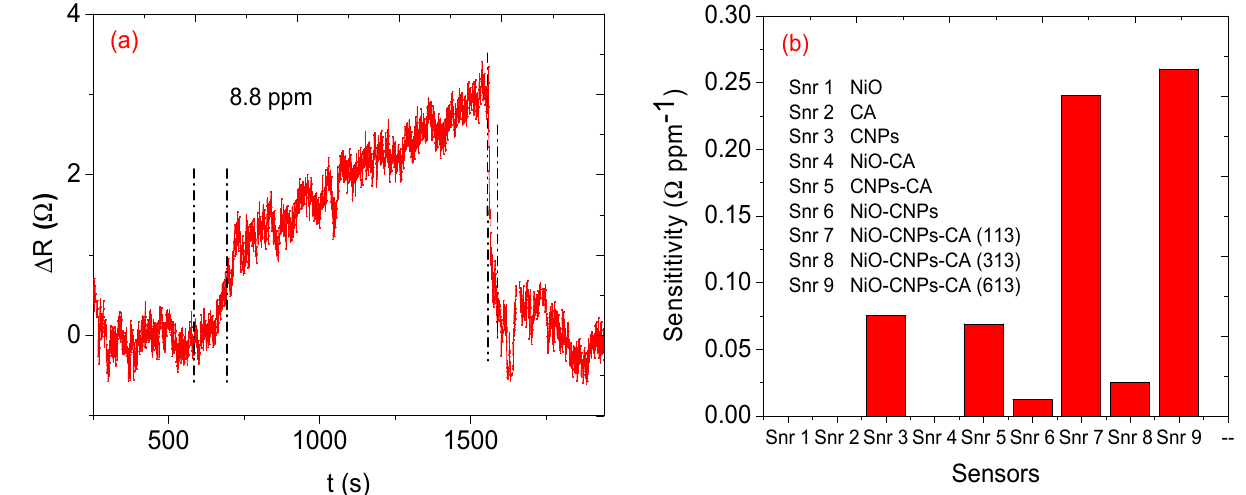
Figure 12. ( a ) Response-recovery time of Snr 7 and ( b ) sensitivity graph for mesitylene. Table 1. Response and recovery time of the sensors during mesitylene detection. Sensors